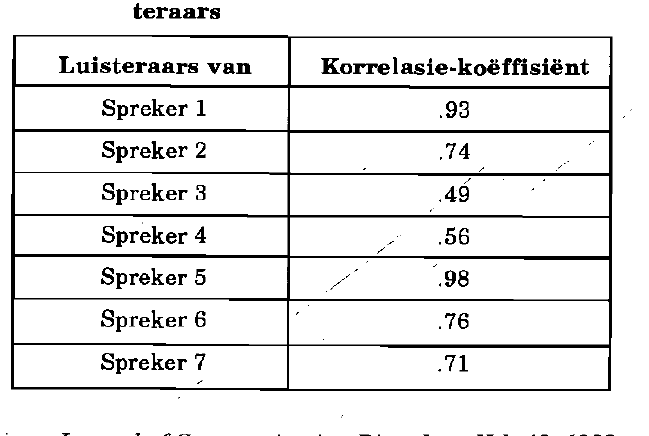
Tabel 10. Korrelasie-koeffisient vir vokaalbeoor- delings van elke spreker se twee